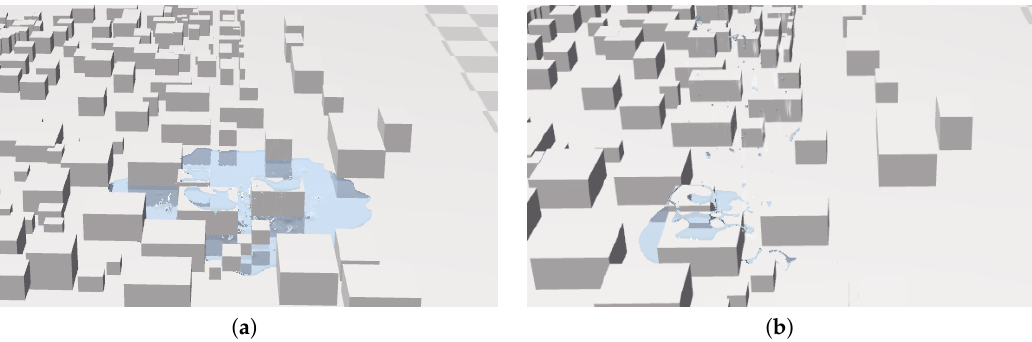
Figure 12. Visualization of the flood simulation environment for 130,000 particles: ( a ) with no absorption coefficients; and ( b ) with absorption